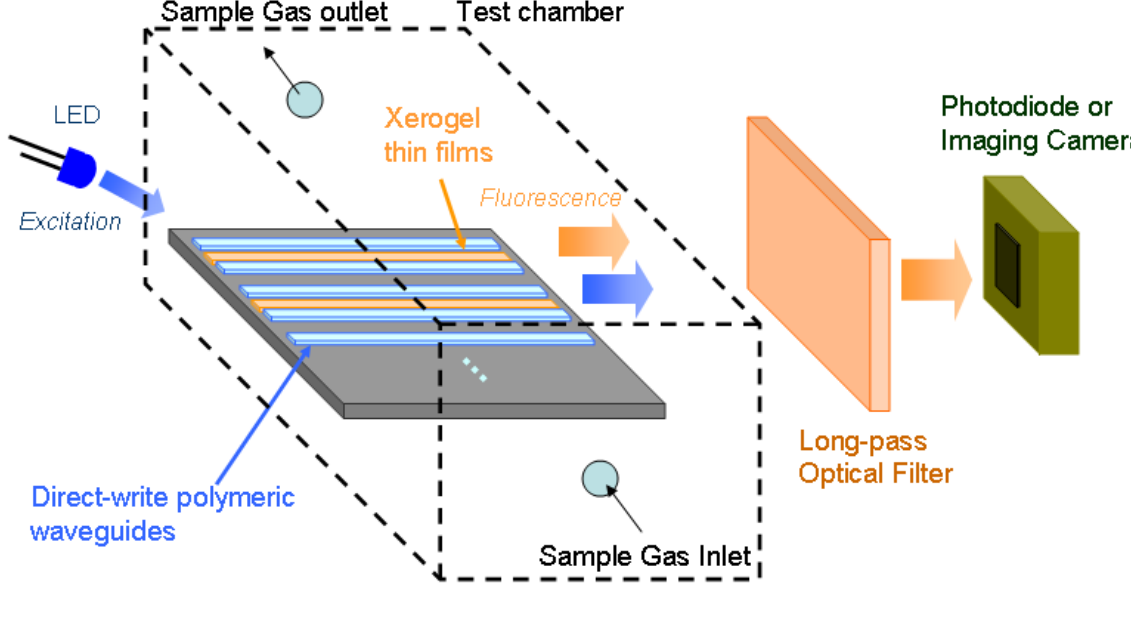
Figure 1. Simplified block diagram of the optical sensor system implementing the polymeric waveguide support platform and xerogel recognition